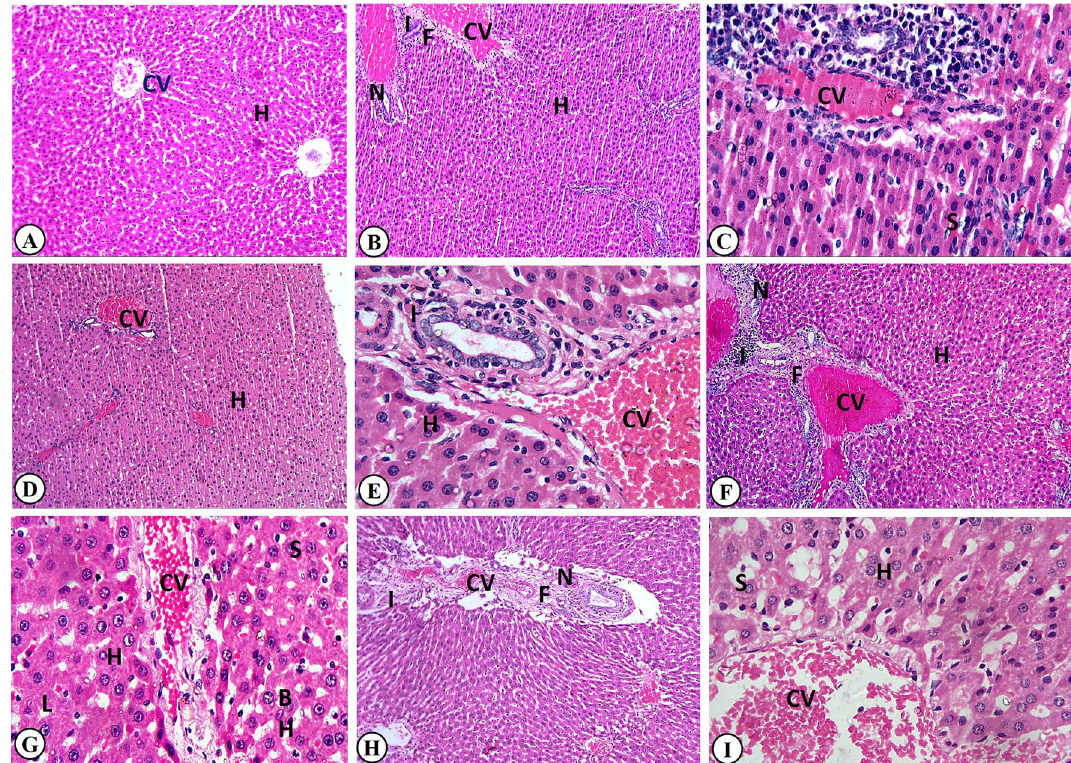
Figure 3. Representative histopathological photomicrographs of hematoxylin-stained cross-sections of rat livers. ( A ) Control group: showing normal architecture with normal hepatocytes in the hepatic cords (H) and central vein (CV) (H&E stain, × 100). Butylated hydroxyanisole-treated group: ( B ) showing hepatocytes disorganization (H), dilated and congested central vein (CV), inflammatory cell infiltrations (I) in the portal area, dilated bile ductules (N), and periportal fibrosis (F) (H&E stain × 100). ( C ) showing dilated and congested central vein (CV) and sinusoids (S), inflammatory cell infiltrations (I) in the portal area, and bile duct hyperplasia (B) (H&E stain, × 400). Potassium sorbate-treated group ( D ): showing hepatocyte disorganization (H) and congested central vein (CV) (H&E stain × 40). ( E ) showing hepatocytes degenerative changes (H) with pyknotic nuclei, congested central vein (CV), dilated blood sinusoids, and inflammatory cell infiltrations (I) in the portal area (H&E stain, × 400). Sodium benzoate-treated group showing: ( F ) hepatocytes disorganized cords (H), congested central vein (CV), mononuclear leucocytic infiltrations (I), newly formed bile ductules (N), and fibrosis (F) in the portal area (H&E stain, × 100). ( G ) Periportal degenerative changes of hepatocytes (H) with pyknotic nuclei, nuclear loss (L) or binucleated hepatocytes (BH), dilated and congested central vein (CV), and hepatic sinusoids dilatation (S) (H&E stain, × 400). Boric acid-treated group showing: ( H ) congested portal vein (CV), inflammatory cell infiltrations (I) in the portal area, newly formed bile ductules (N), and portal fibrosis (F) (H&E stain, × 100). Calcium propionate-treated group showing: ( I ) congested portal vein (CV) and hepatic sinusoids(S) as well as degenerative changes of hepatocytes (H) with pyknotic nuclei (H&E stain, ×